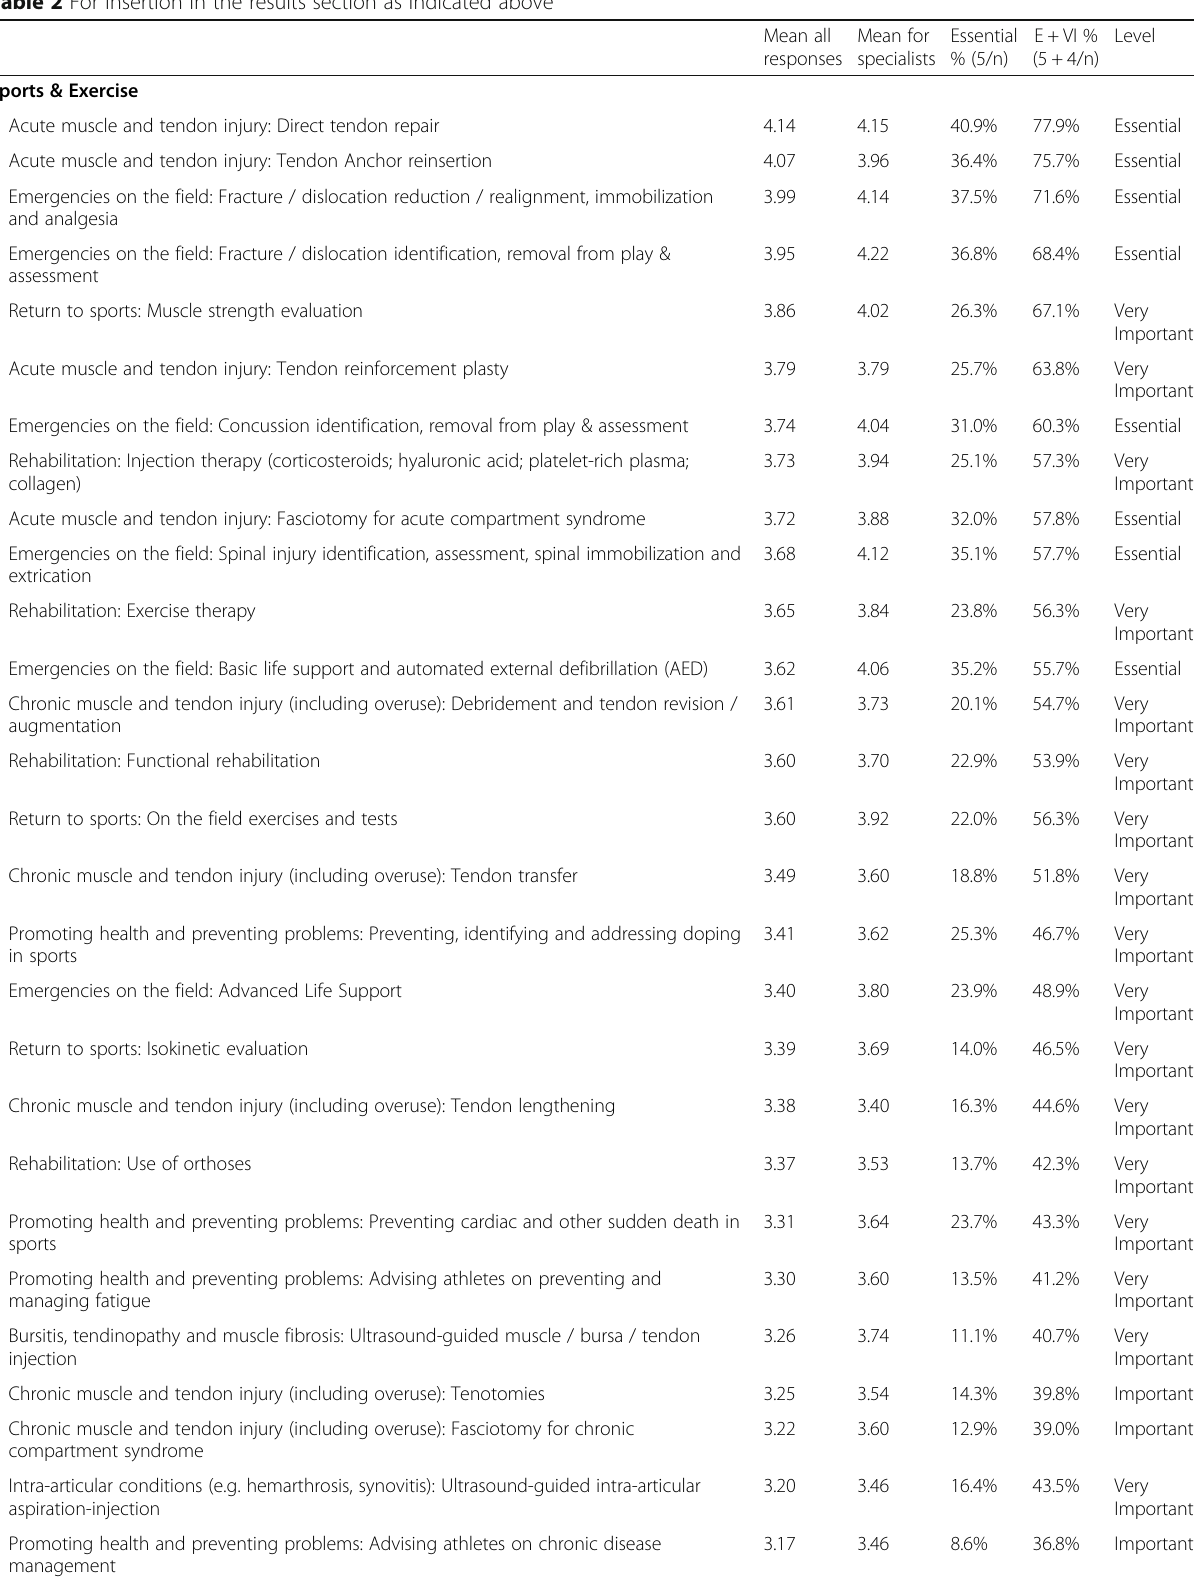
Table 2 For insertion in the results section as indicated above